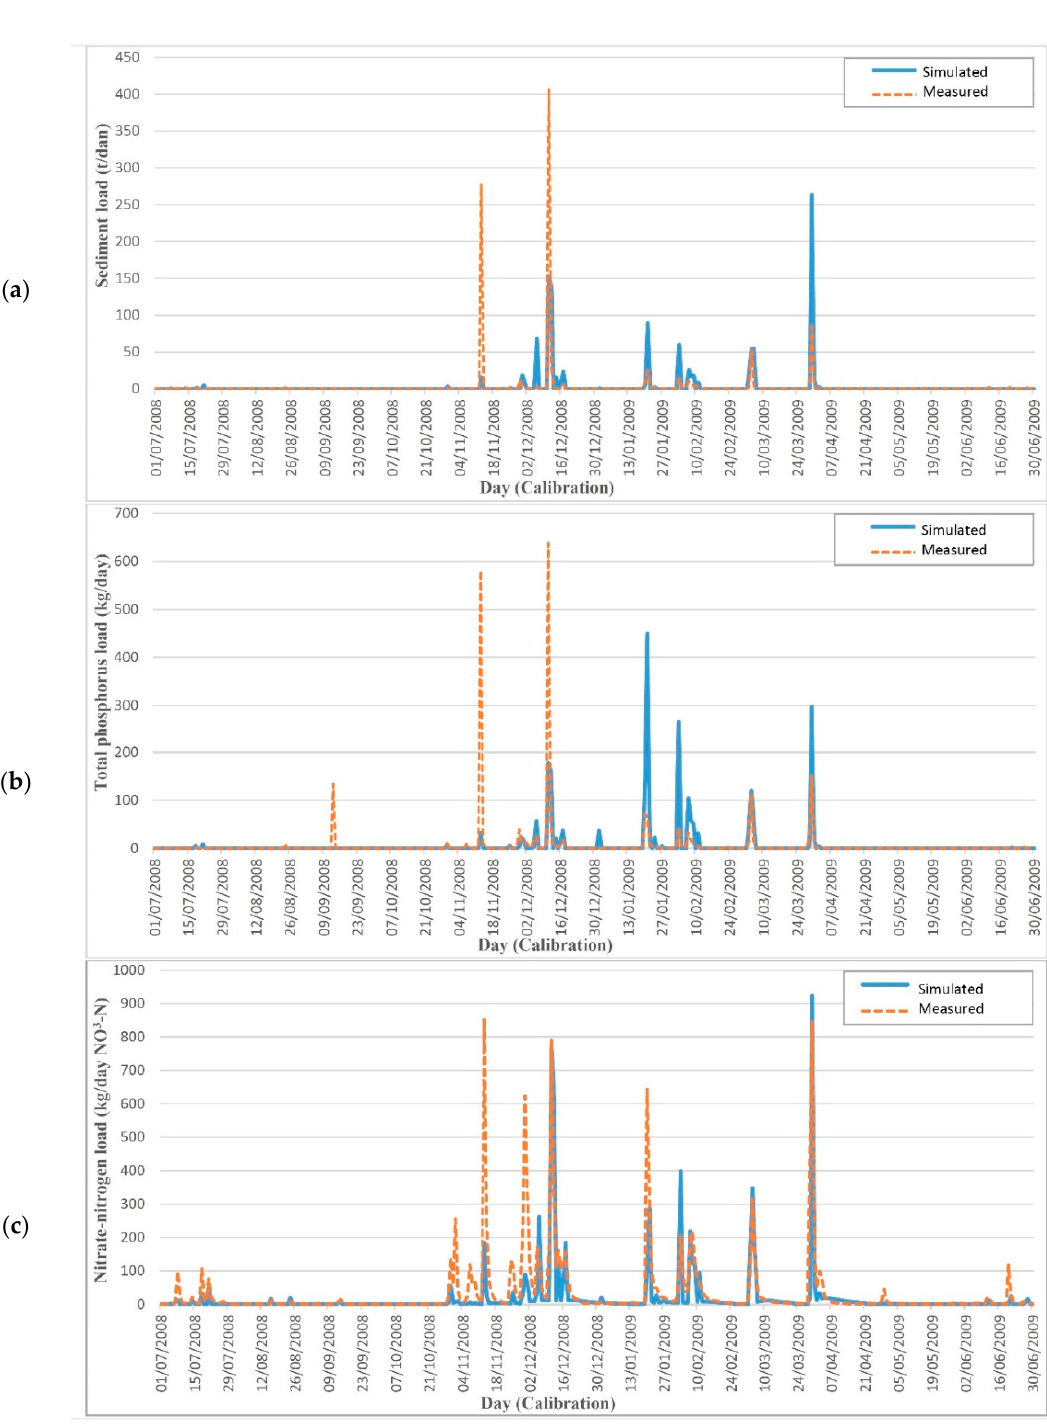
Figure 4. Comparison between measured and simulated daily sediment loads ( a ) and total phosphorus (TP) ( b ) and nitrate nitrogen (NO 3 -N) loads ( c ) for the calibration period (2008–2009) at the Kožbanjšˇcek stream catchment main outflow.